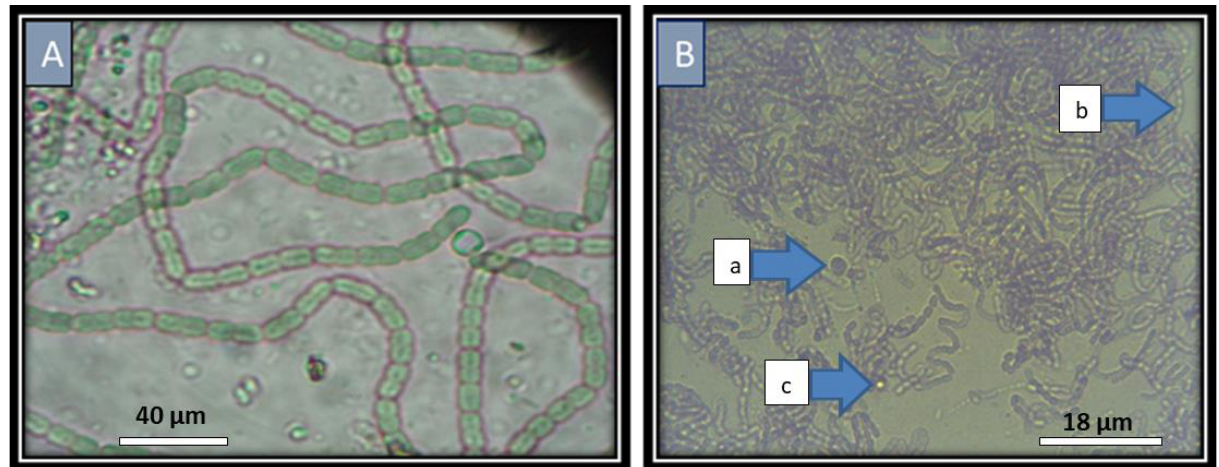
Figure 1. The two isolated cyanobacteria identified based on their morphological characteristics. ( A ) Anabaena oryzae with thallus green, which is gelatinous and memberanous. Trichomes are short and straight. Cells are barrel-shaped, the same length as it is broad, 4 µ m broad, 5 µ m long. Heterocysts are terminal and intercalary; intercalary heterocysts are subspherical, are 4–5 µ m broad, and are 4–5 µ m long; terminal heterocysts are conical and longer than they are broad, are 3–3.5 µ m broad, and are 4–4.5 µ m long. There are 3–6 akinetes in a series, and they are sub-spherical, are 5–6 µ m broad, and are 6–7 µ m long. ( B ) The Nostoc muscorum culture has dark green trichomes and no ramifications. It was uniseriate, single, aggregated, and showed neither polarity nor tapering. No sheath was formed. Trichomes are composed of three sizes and shapes of cells; (a) barrel cells (5–6 × 5.5–7 µ m); (b) granular, ellipsoidal cells (5 × 5.5–7.5 µ m); (c) yellowish-brown rounded cells of 8.9 µ m in diameter. Few heterocysts were observed. They were of a single occurrence with two position, intercalary and terminal.